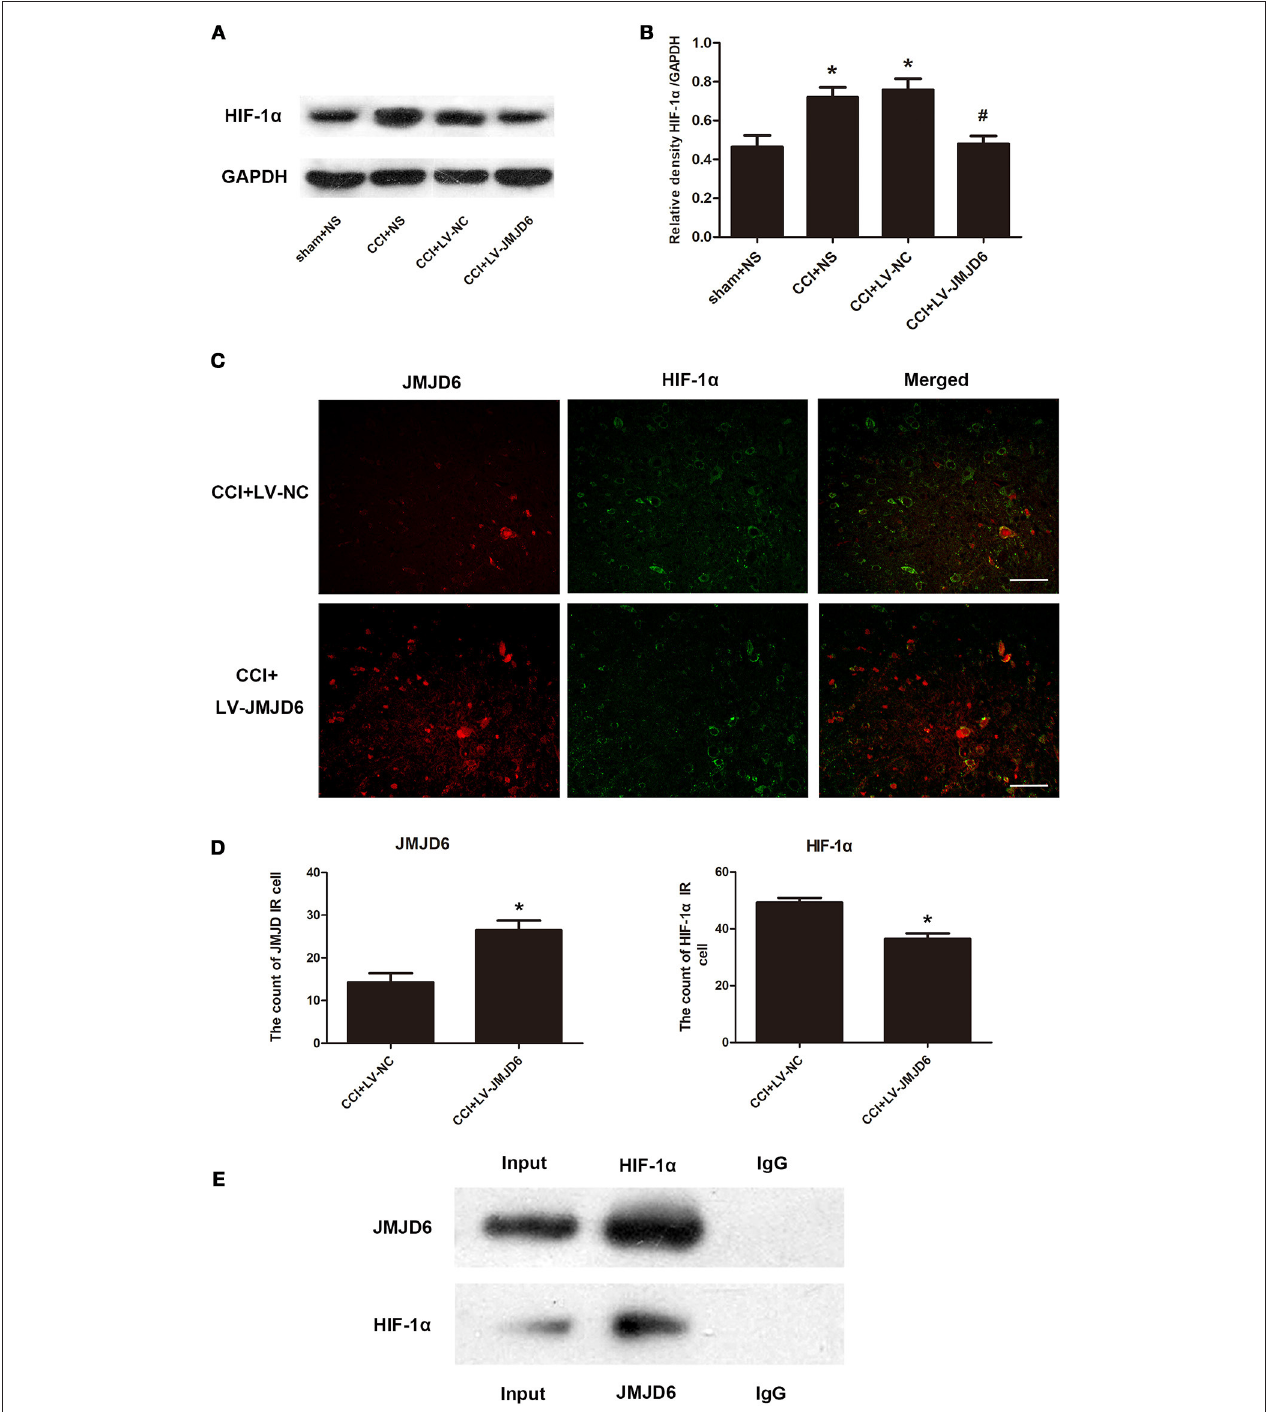
FIGURE 5 | JMJD6 may exert its function in neuropathic pain by regulating HIF-1 α . (A,B) HIF-1 α is decreased in the spinal cord after intrathecal injection of LV-JMJD6 following CCI surgery ( n = 4). # p < 0.05, CCI + LV-JMJD6 vs. CCI + LV-NC group; * p < 0.05, CCI + LV-JMJD6 vs. sham + NS group. (C) Double immunofluorescence labeling for JMJD6 (red) and HIF-1 α (green) in the rat spinal dorsal horn (L4–6 spinal cord on day 14 post-CCI). Scale bars = 50 µ m. (D) Quantitative estimation of JMJD6 and HIF-1 α in immunofluorescence images. Immunoreactive cells were counted and illustrated ( n = 4). * p < 0.05, CCI + LV-JMJD6 vs. CCI + NS and CCI + LV-NC groups. (E) Co-immunoprecipitation of JMJD6 and HIF-1 α in PC12 cells. Immunoprecipitation of JMJD6 followed by western blot for HIF-1 α , and immunoprecipitation of HIF-1 α followed by western blot for JMJD6.